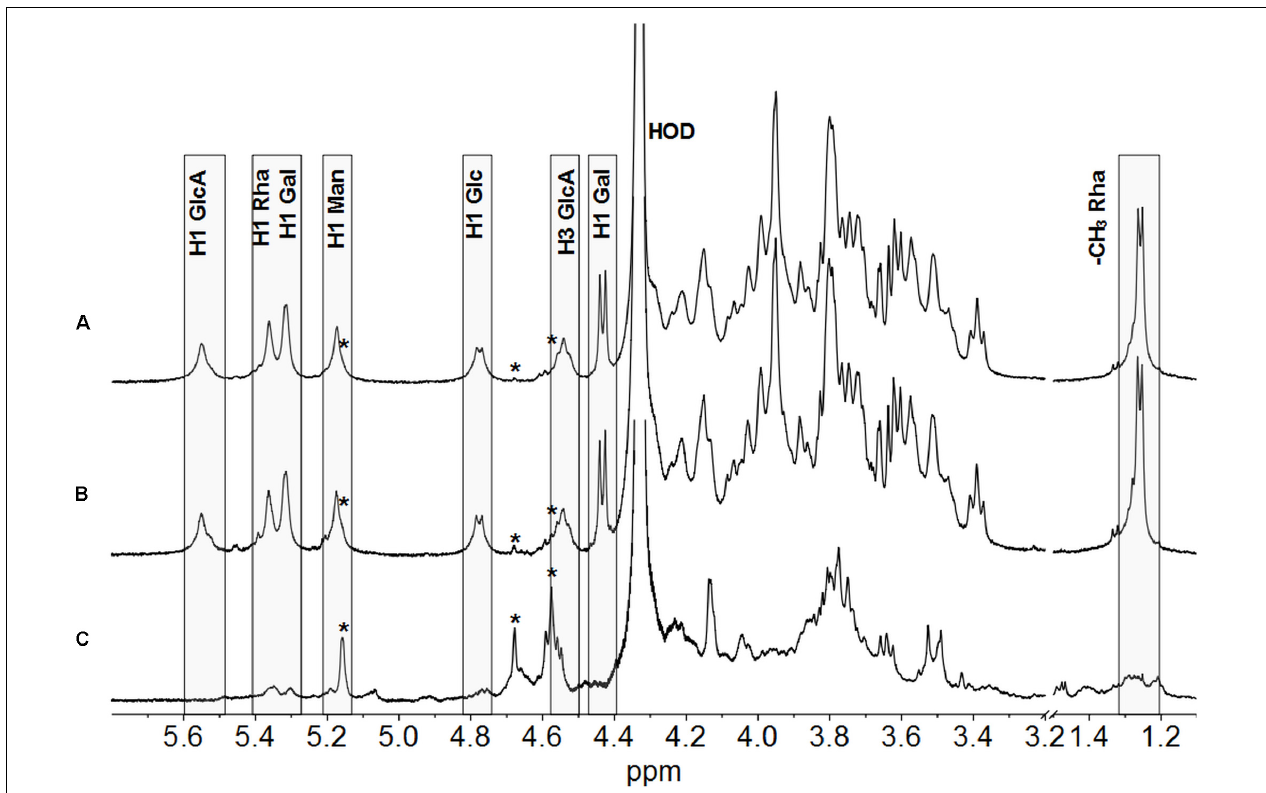
FIGURE 4 | 1 H NMR spectra of the polysaccharides produced by P. phymatum wild type (A) , a P. phymatum bceN complemented mutant (B) , and a P. phymatum bceN mutant (C) . Spectra were recorded at 500 MHz and 70 ◦ C. Resonances attributed to the anomeric protons of CEP, residual water (HOD), H3 of glucuronic acid, and methyl group of rhamnose are reported. Boxes show diagnostic resonances of cepacian. H1, Anomeric proton; GlcA, Glucuronic acid; Rha, Rhamnose; Gal, Galactose; Man, Mannose; Glc, Glucose. Low intensity signals belonging to the polymer produced by the bceN mutant strain are indicated by stars.